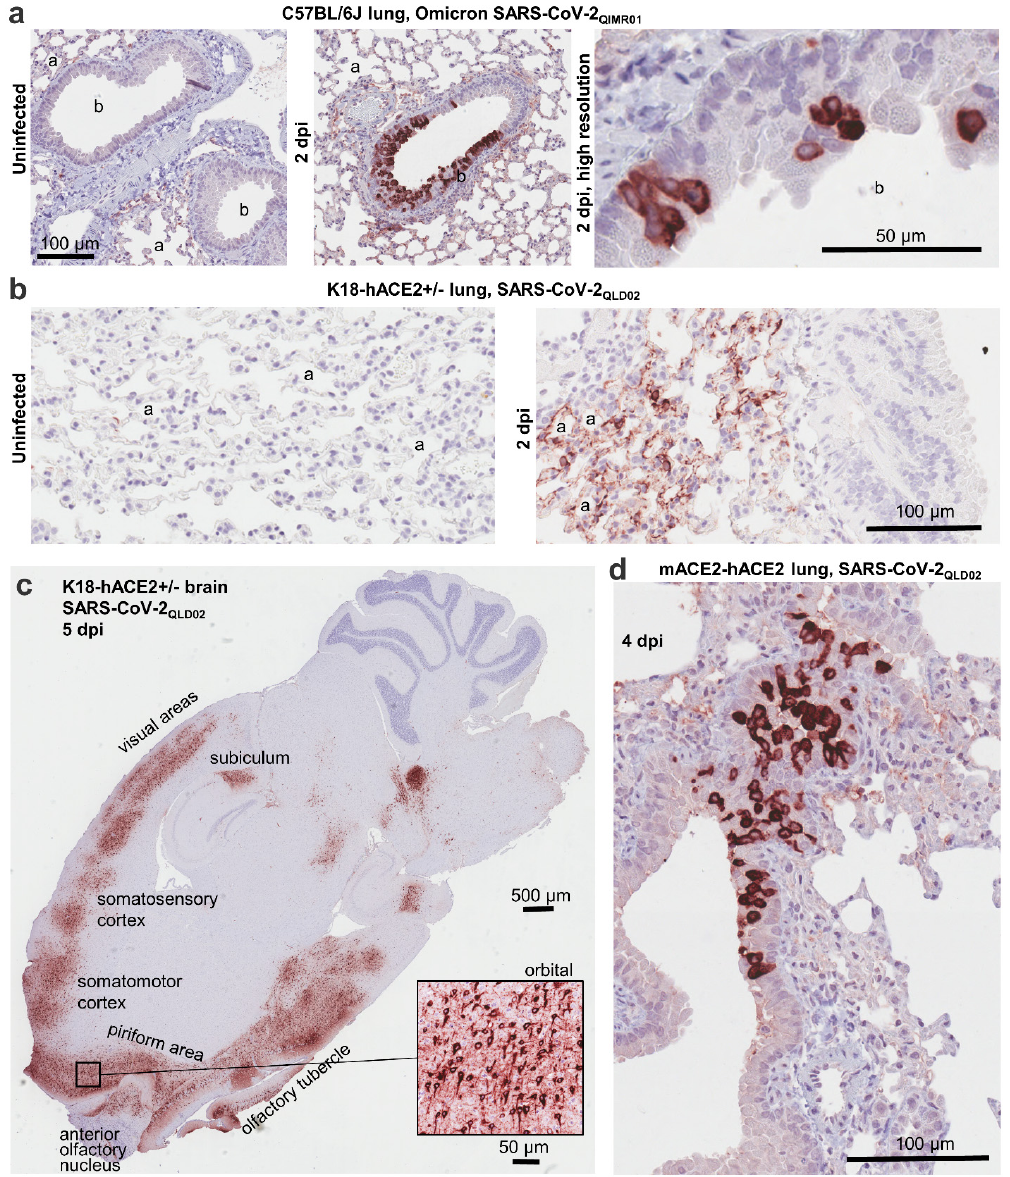
Figure 1. Immunohistochemistry using SCV2-1E8. ( a ) Uninfected lungs (left) and infected lungs at 2 dpi (two images on the right) from C57BL/6J mice infected with an omicron isolate, SARS-CoV-2 QIMR01 . ( b ) Uninfected lungs (left) and infected lungs at 2 dpi (right) from K18-hACE2 +/ − mice infected with an original strain isolate, SARS-CoV-2 QLD02 . ( c ) Brain from K18-hACE2 +/ − mice on 5 dpi with SARS-CoV-2 QLD02 . Stained areas of the brain are annotated (approximate); insert taken from the orbital region of the brain. ( d ) Infected lungs 4 dpi from mACE2-hACE2 mice infected with SARS-CoV-2 QLD02 . Within the IHC panels of (a) and (b), alveolar spaces (a) and bronchioles (b) are indicated.